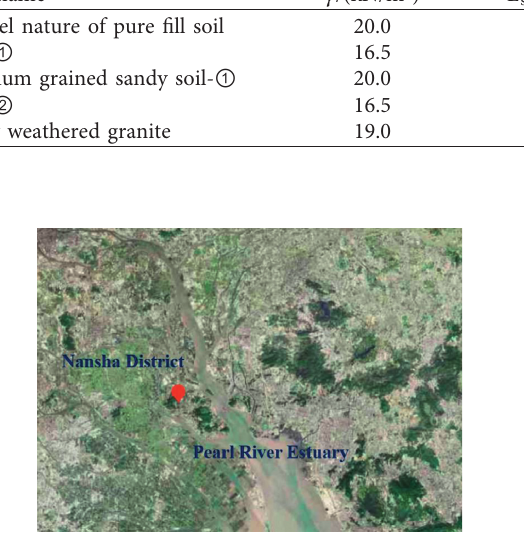
Figure 5: Location relationship between Nansha and Pearl River Estuary.